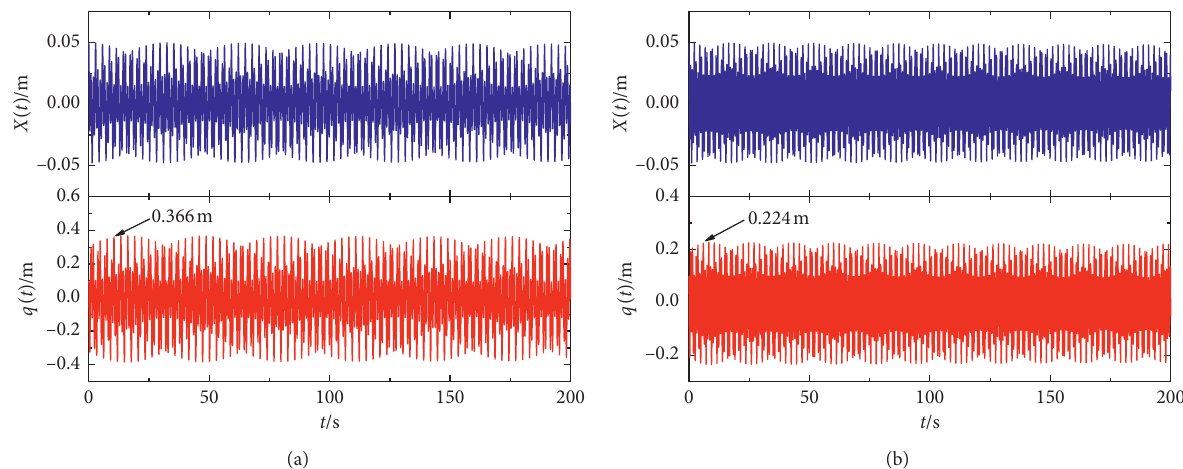
Figure 4: Displacement response (with 1:1 response mode): (a) the first calculation method of dynamic tension; (b) the second calculation method of dynamic tension.